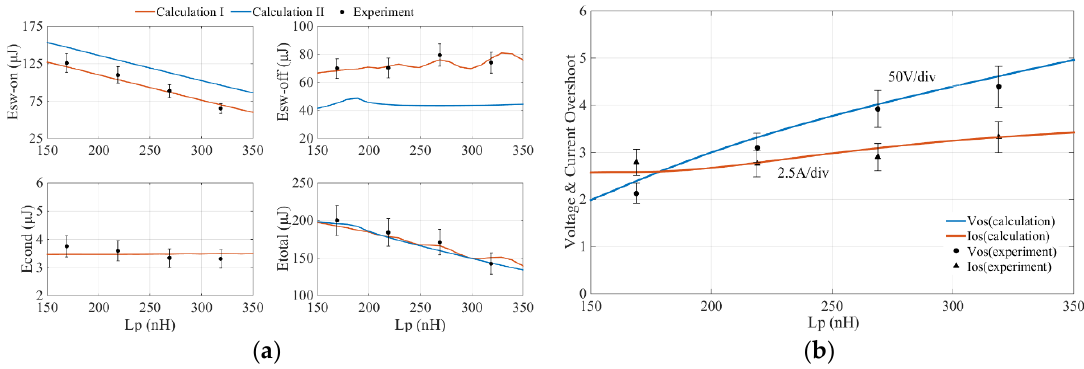
Figure 14. Comparison between experiment and calculation under the influence of loop parasitic inductance L p . ( a ) Power losses. ( b ) Voltage overshoot and current overshoot. Common Source Stray Inductance: L s2 di ff er from other stray inductances of PCB traces since